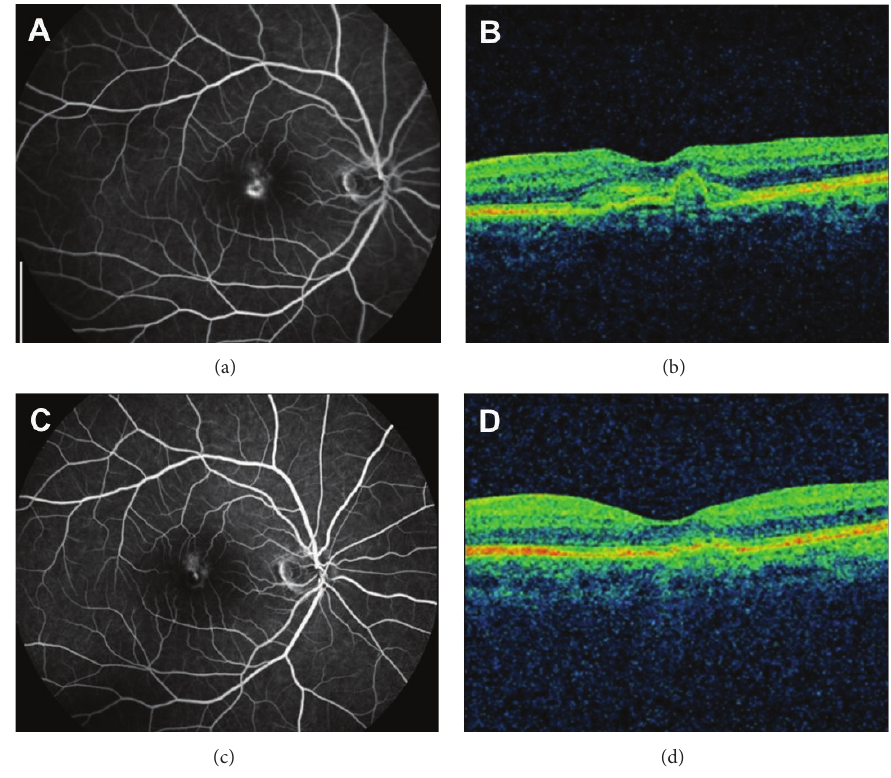
Figure 1: Fluorescein angiography and horizontal optic coherence tomography findings in mid and early group patients. (a) Fluorescein angiography at late stage and (b) horizontal optic coherence tomography cross-sections of the macula in the right eye of a 28-year-old woman with subretinal idiopathic choroidal neovascularization and intraretinal edema. Her best-corrected visual acuity (BCVA) was 63 letters at baseline. Twelve months later, the BCVA was 80 letters and no obvious leakage of choroidal neovascularization could be observed (c). The retinal profile was normal